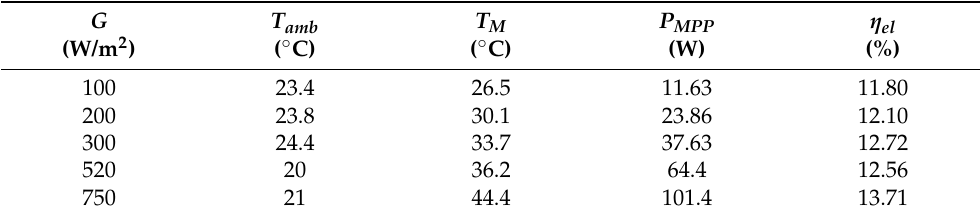
Table 2. Measurement results for the standard PV module model: